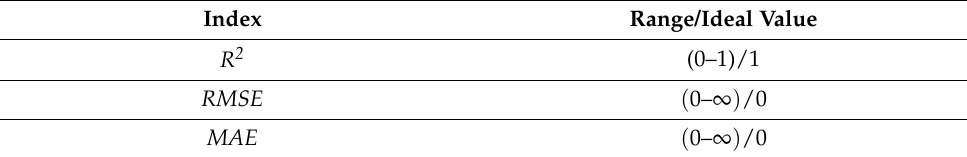
Figure 2. Flowchart of GEP modelling. Table 5. Ideal values of performance